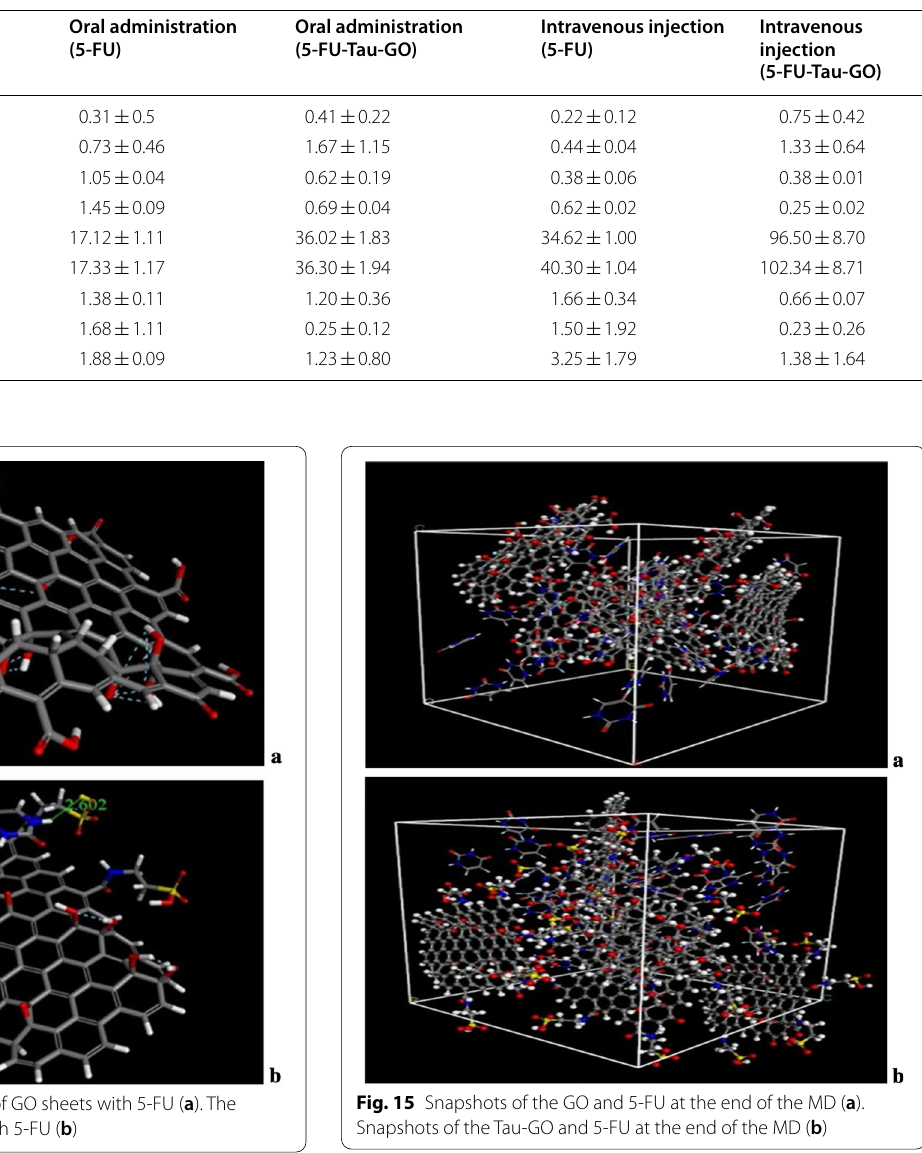
Table 1 The basic pharmacokinetic parameters of 5-FU and 5-FU-Tau-GO through oral administration and intravenous injection